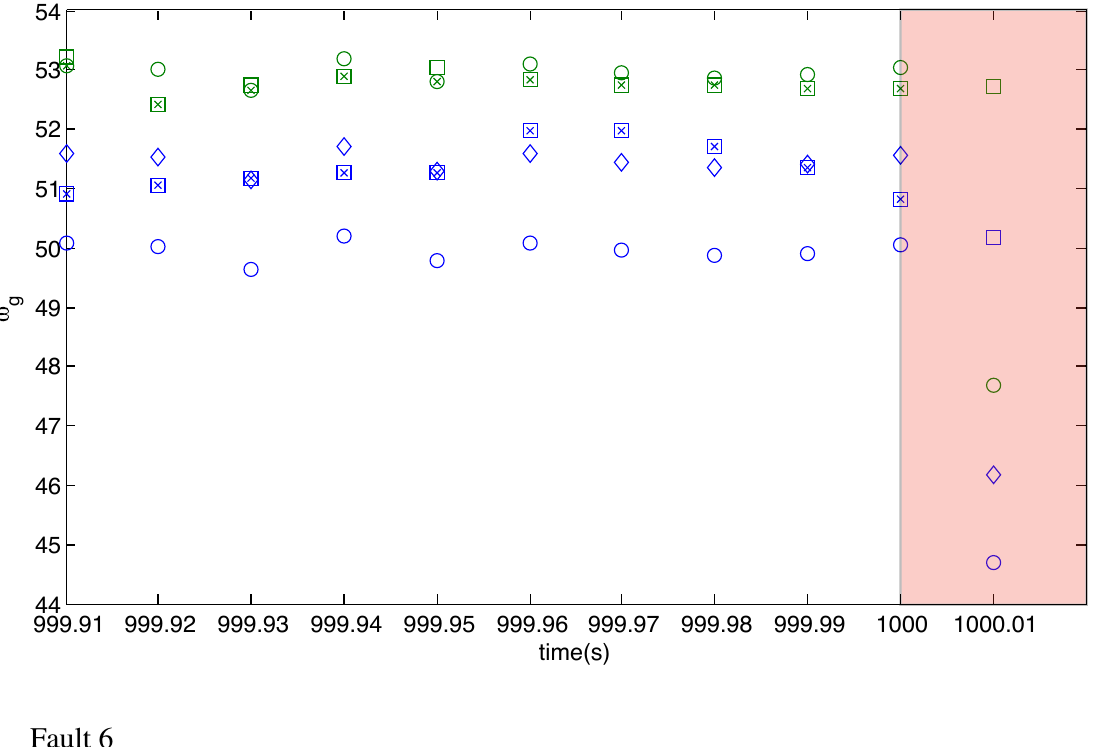
Detection of fault 5, (cid:5) : current measurement ω g , m